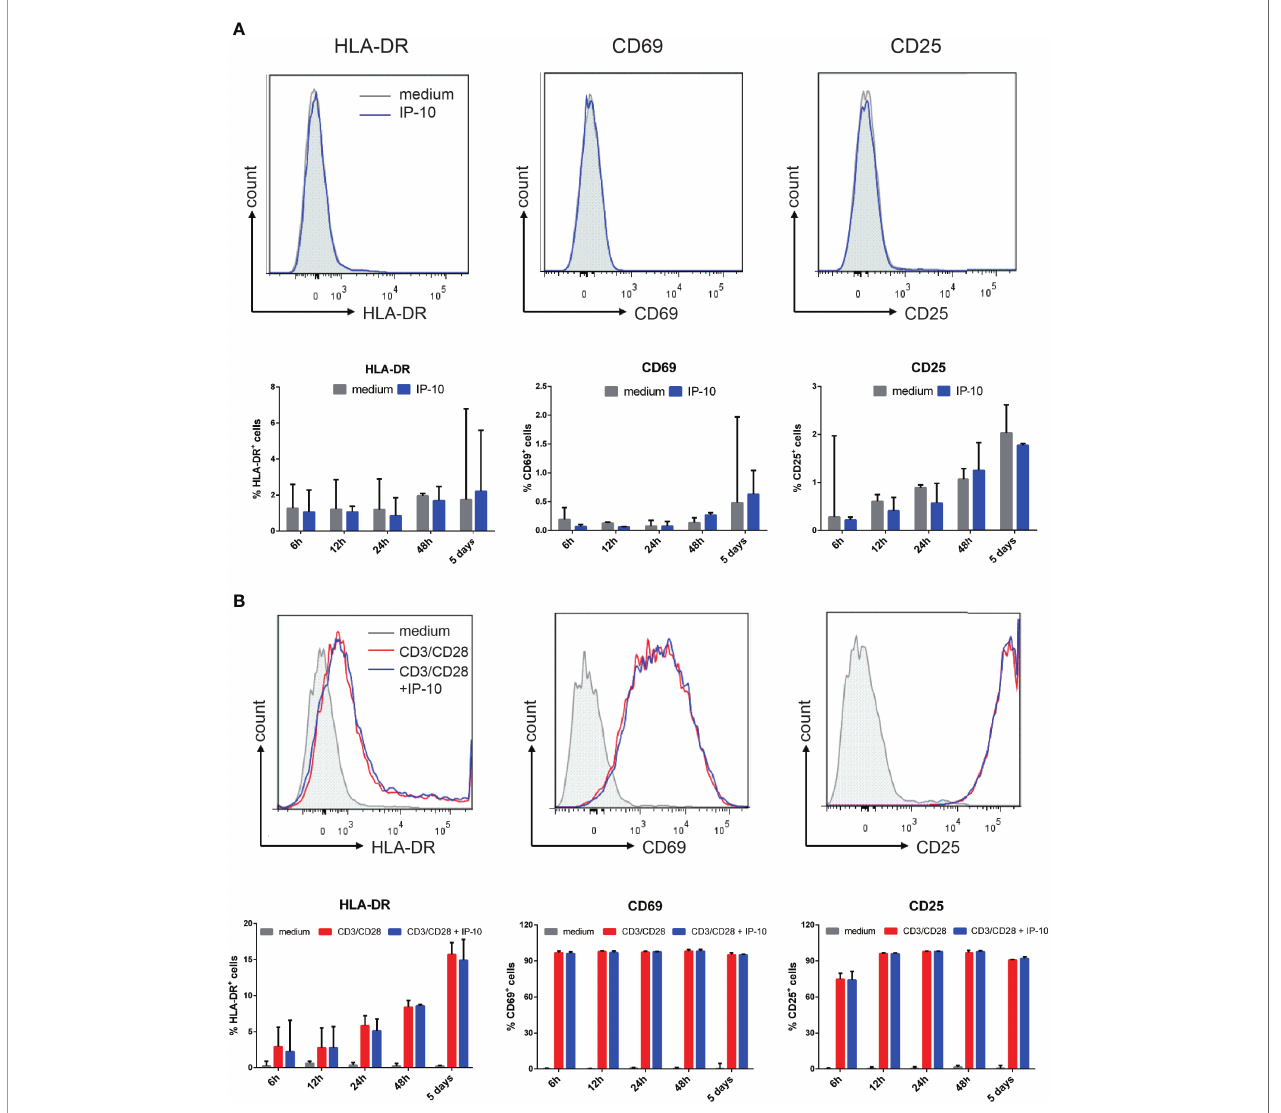
FIGURE 4 | IP-10 does not promote resting memory CD4 + T cell activation. (A, B) Effect of IP-10 on the expression of the resting memory CD4 + T cell activation markers HLA-DR, CD69, and CD25 (A) and on the activation of resting memory CD4 + T cells by CD3/CD28 (B) at 6, 12, 24, and 48 h and 5 days post-treatment; representative fl ow cytometry plots from 3 participants and quantitative analyses are shown. The time point for HLA-DR, CD69, and CD25 of the representative fl ow cytometry plots are 5 days, 6 h and 24 h, respectively. The nonparametric Wilcoxon matched-pairs test was used for intergroup